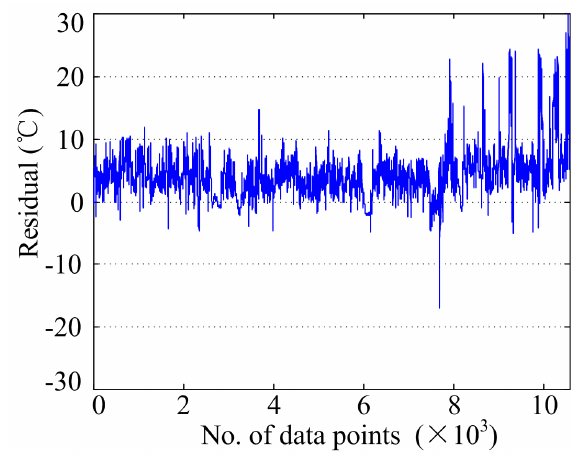
Figure 15. Residual of model for temperature of generator bearing B in WT